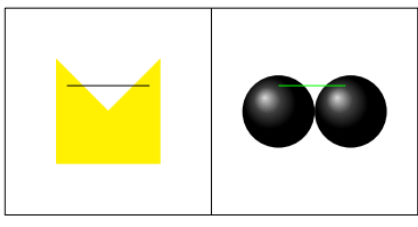
Figure 7. Non-convex sets.